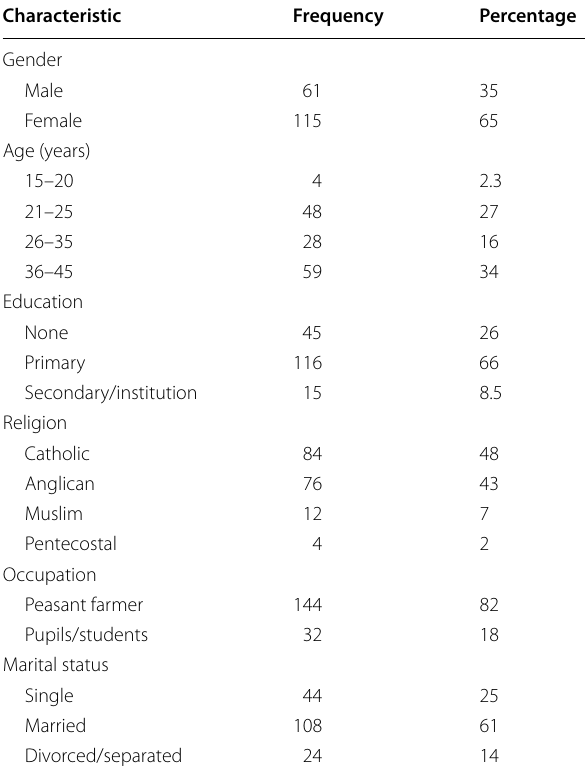
Table 1 Socio-demographic characteristics of the